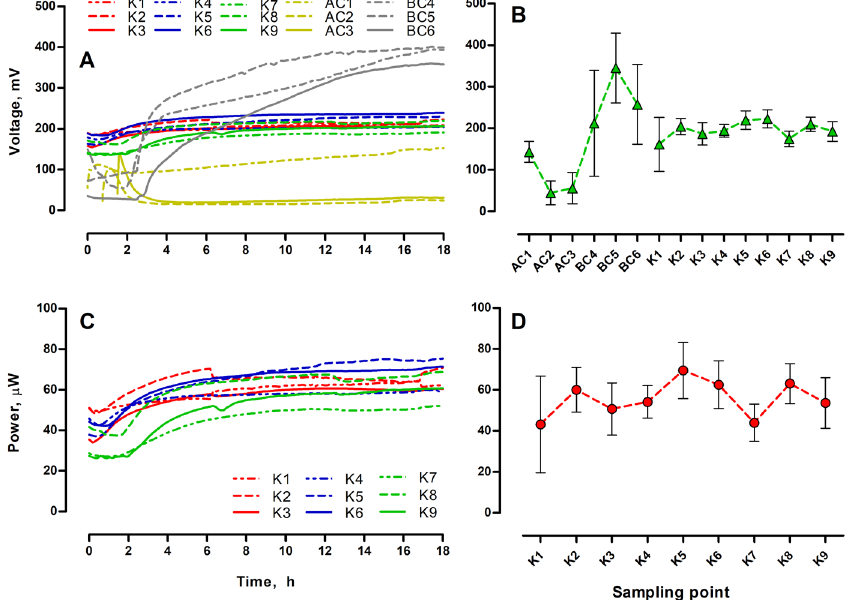
Figure 2. Real time potential ( A ), power output ( C ) and the corresponding average values calculated for the whole experimental period ± SD ( B , D ). Data represent average ± SD.